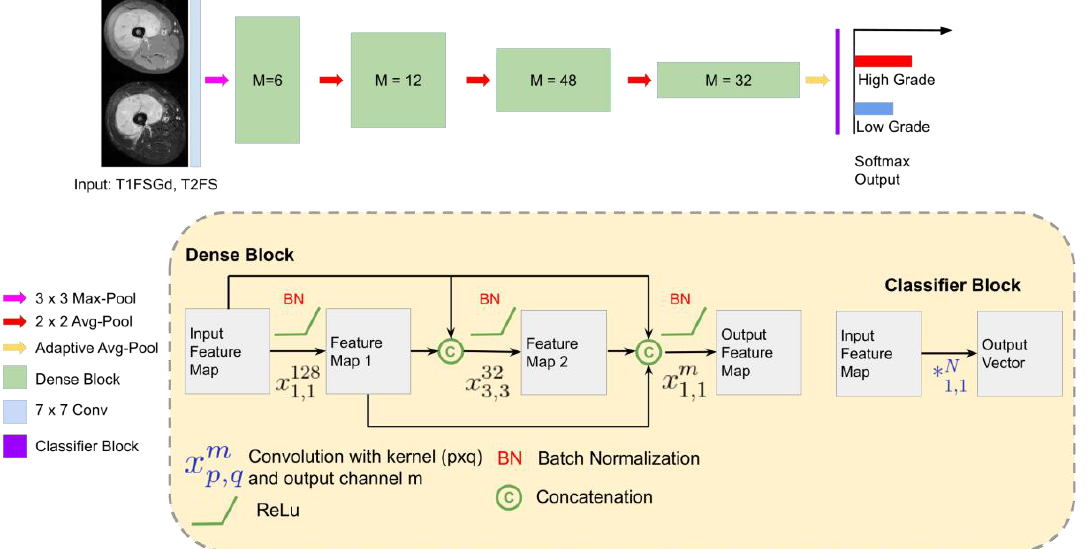
Figure 1. Deep learning strategy: DenseNet 161 architecture for tumor grading in MRI [44]. The network receives the 2D transversal slice from the VOI and outputs the probability of the image for the two classes. In the lower part of the figure, each component of the DenseNet is described. Abbreviations: Avg: Average, T1FSGd: contrast-enhanced and fat-saturated T1-weighted sequence, T2-weighted fat-saturated (T2FS) sequence.